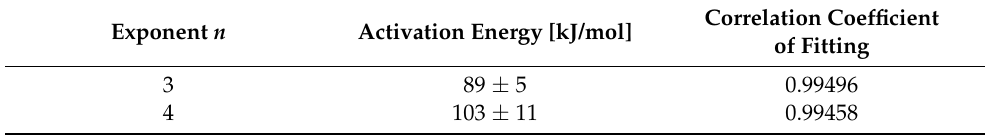
Table 2. The activation energy and the correlation coefficient obtained for fitting of ln versus 1/ T with the exponent values of n = 3 and 4. In the analysis, the Cu foams with the ligament sizes between 540 and 740 nm were used (see Table 1).